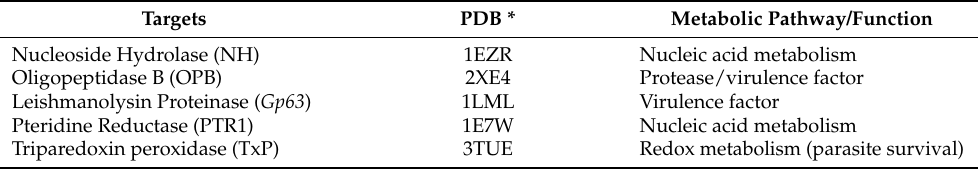
Table 1. Main targets for antileishmanial chemotherapy for Leishmania major species. Targets PDB * Metabolic Pathway/Function Nucleoside Hydrolase (NH) 1EZR Nucleic acid metabolism Oligopeptidase B (OPB) 2XE4 Protease/virulence factor Leishmanolysin Proteinase ( Gp63 ) 1LML Virulence factor Pteridine Reductase (PTR1) 1E7W Nucleic acid metabolism Triparedoxin peroxidase (TxP) 3TUE Redox metabolism (parasite